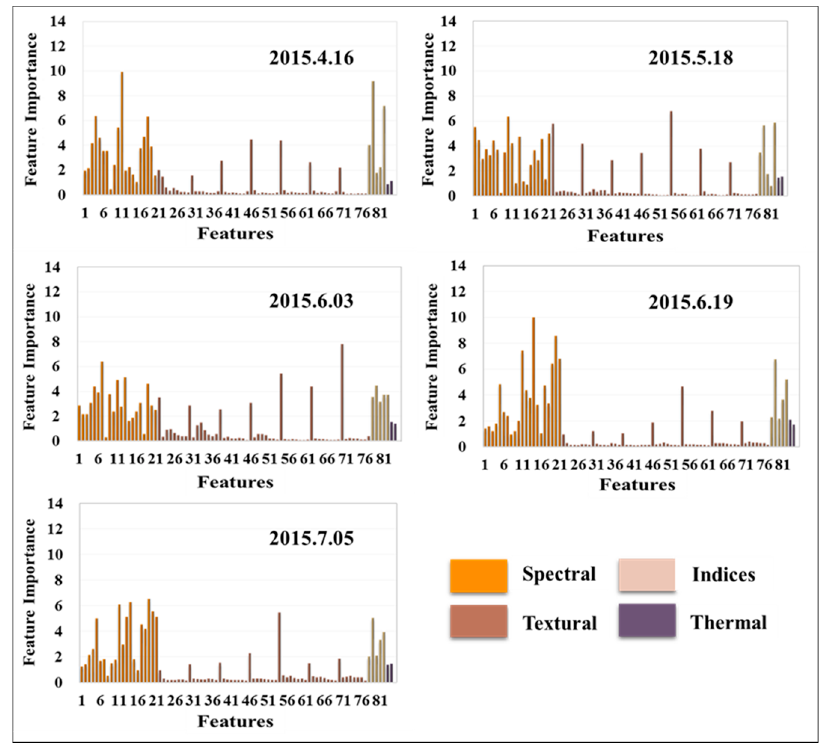
Figure 5. Feature importance of each period in Jizhou (the abscissa corresponds with the order of the features in Table 2). Table 4. Top 20 selected features from RF (random forest) for mapping PMF in different parts of the growing season.